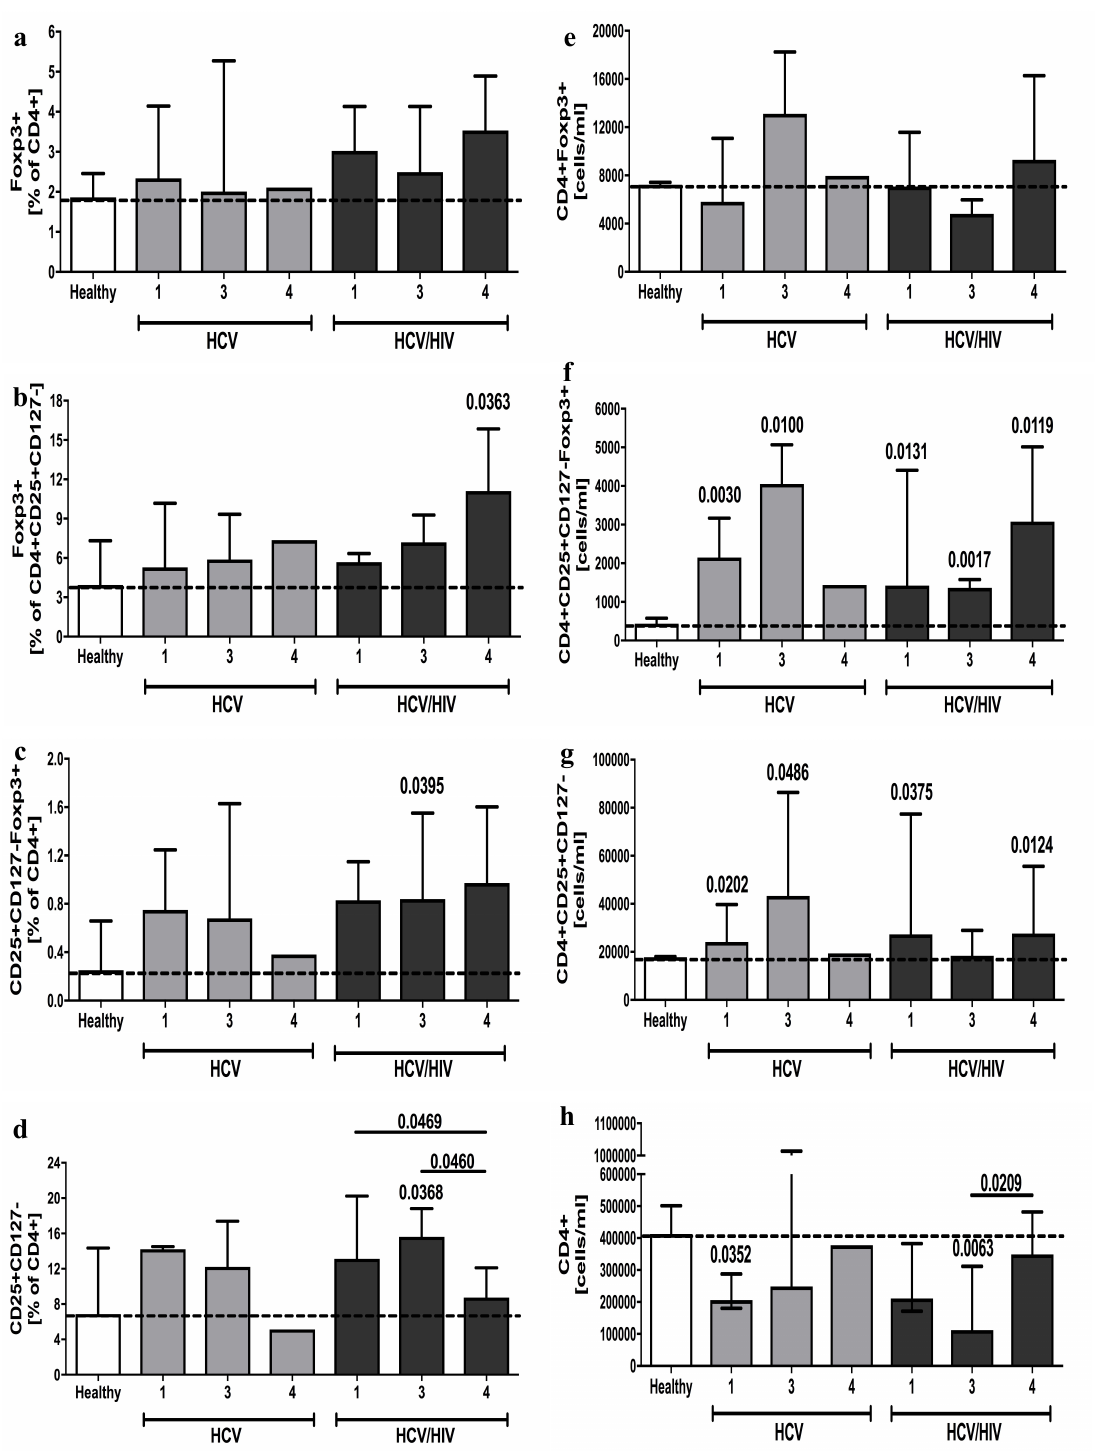
Figure 4. HCV virus genotype effects on frequency and absolute numbers of regulatory T cells in HCV-infected and HCV/HIV-coinfected patients. Treg-related parameters analyzed in context of frequencies: Foxp3 + in CD4 + ( a ) and numbers: Foxp3 + ( e ), CD25 + CD127 − Foxp3 + ( f ), CD25 + CD127 − ( g ) CD4 + lymphocytes, and total CD4 + cells ( h ). Significant changes in relation to healthy controls indicated directly above specific group column; additional differences distinguished with lines connecting significantly different